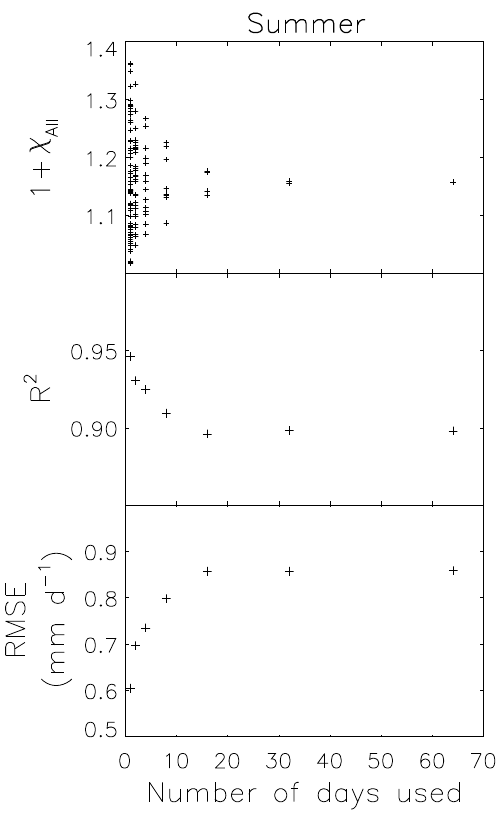
Fig. 9. Accuracy of the total correction factor (1 + χ All ) versus the number of days used to calculate the mean diurnal cycle. (Data are for summer only.)